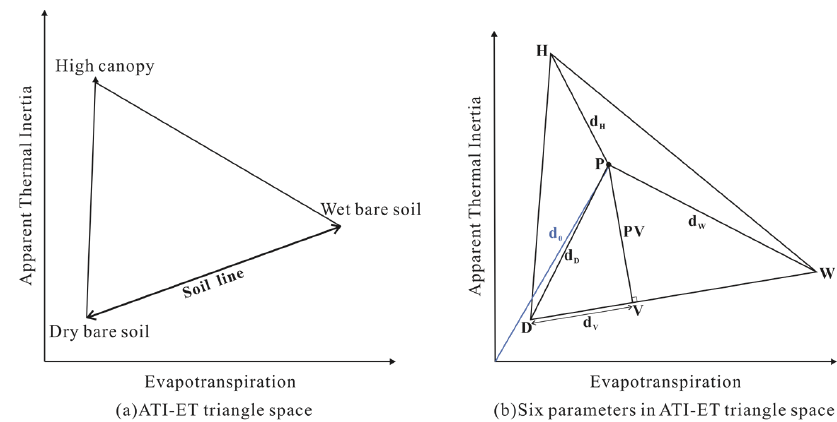
Figure 3. Six parameters used for estimating SM.